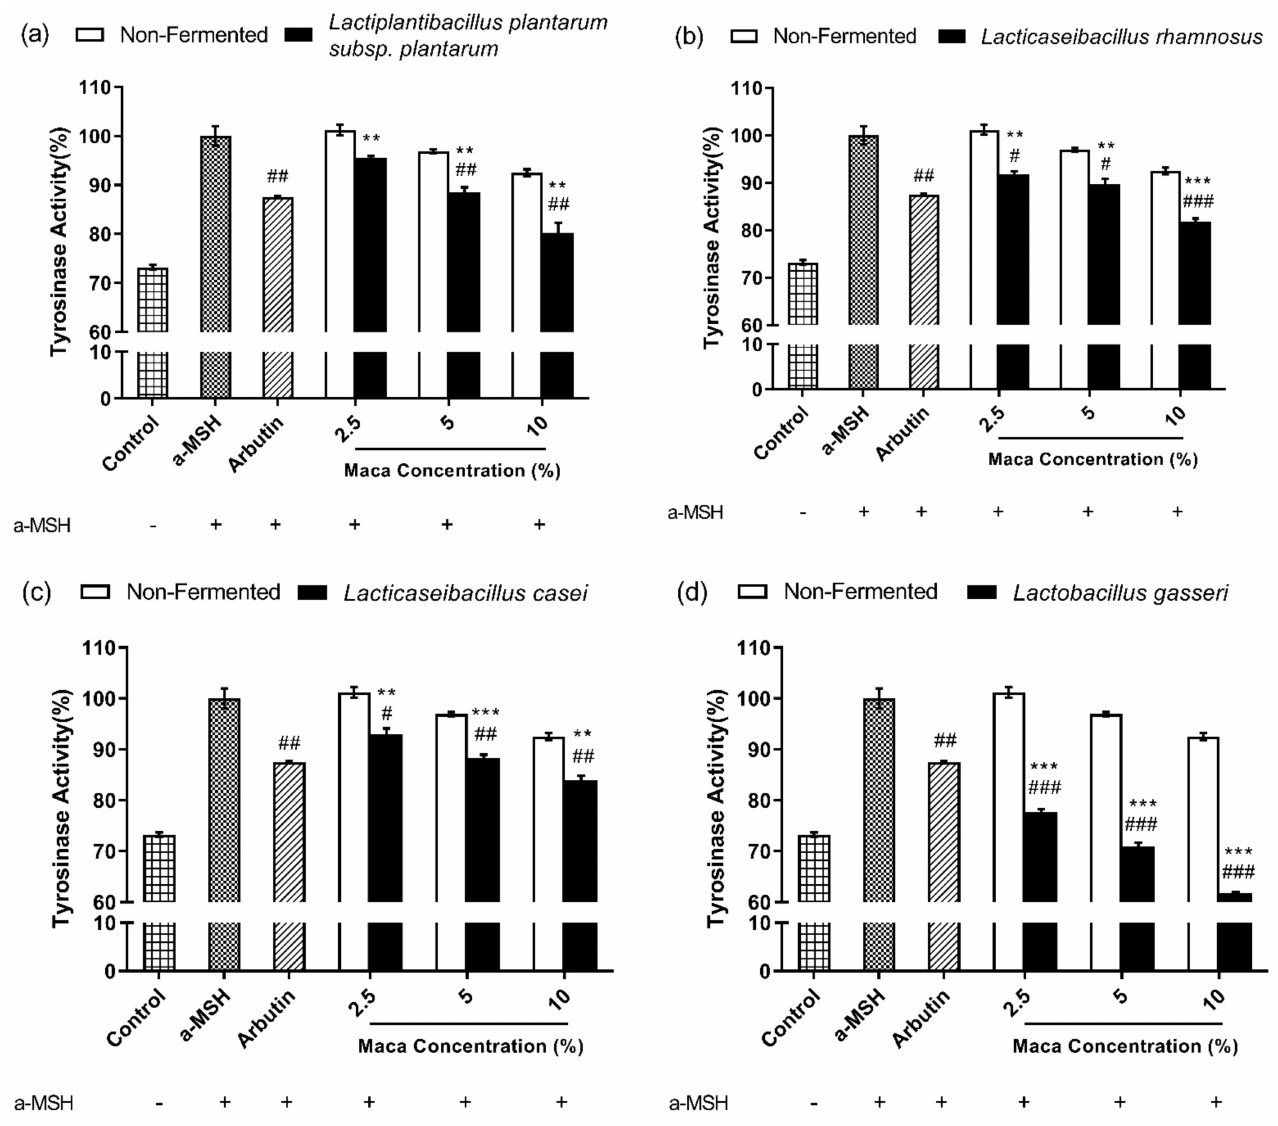
Figure 9. Effects of non-fermented and fermented maca root extracts on intracellular tyrosinase activity. Intracellular tyrosinase activity of B16F10 cells treated with maca root extracts fermented using ( a ) Lactiplantibacillus plantarum subsp. plantarum KCTC 3108, ( b ) Lacticaseibacillus rhamnosus KCTC 5033, ( c ) Lacticaseibacillus casei KCTC 3109, and ( d ) Lactobacillus gasseri KCTC 3143. Error bars, mean ± SD. # p < 0.05, ## p < 0.005, and ### p < 0.0005 compared to the α -MSH group. ** p < 0.005 and *** p < 0.0005 compared to the same concentration of the non-fermented maca root extract